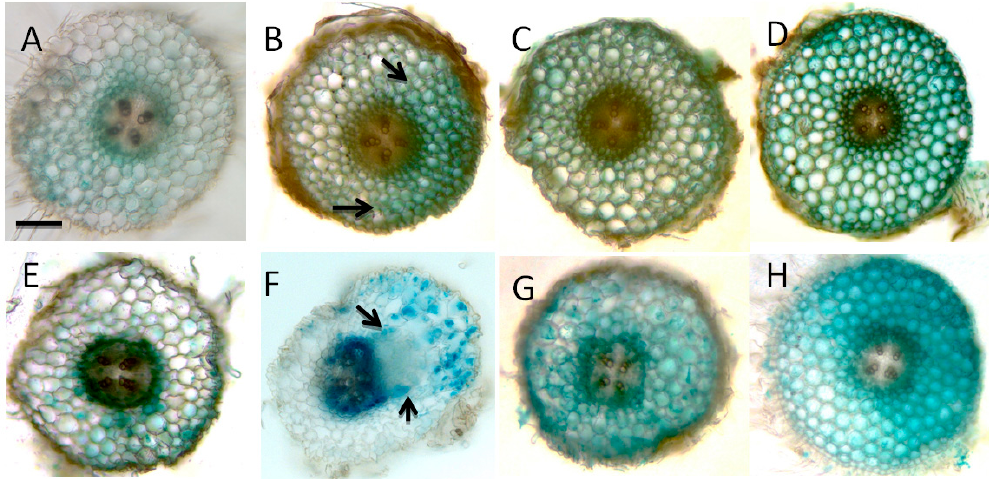
Figure 4. GH3:GUS expression indicating auxin responses to nitrate and S. meliloti treatment. Sections in A – D show cross sections through the inoculation site at 24 h p.i., sections E – H at 48 h p.i. ( A , E ) Mock-inoculated roots in the absence of nitrate; ( B , F ) S. meliloti (1021)-inoculated roots in the absence of nitrate; ( C , G ) Mock-inoculated roots in the presence of 2.5 mM nitrate; ( D , H ) S. meliloti (1021)-inoculated roots in the presence of 2.5 mM nitrate. Pictures are representative of at least ten analyzed roots for each treatment. Arrows in B indicate the localized increase in auxin response to S. meliloti , arrows in F indicate a nodule primordium with localized GH3:GUS expression at the base of the primordium and in cortical cells overlying the primordium, whereas GH3:GUS expression in the presence of nitrate was more diffuse in the cortex. Magnification bar represents 200 µm.